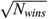
Selection of window size for the calculation of the power spectrum.(A) Power spectrum of a Poisson spike train generated from a pure oscillatory rate function (f
0 = 12 Hz, r
0 = 40 sp/s and m = 0.5). Left, power spectrum calculated with a resolution of 1 Hz. Right, power spectrum with a resolution of 0.1 Hz. (B) Power spectrum of a Poisson spike train generated from a jittered oscillatory rate function (f
0 = 11.5–12.5 Hz, r
0 = 40 sp/s and m = 0.5). Left, 1 Hz resolution. Right, 0.1 Hz resolution. (C) An example of a single GPi neuron showing a peak with a width of ~1 Hz. (D) The effect of window size and resolution in the power spectrum at different recording durations during a fixed firing rate and a fixed firing modulation. The SNR increases on a scale of Nwins. The dotted black lines indicate the square root fit.